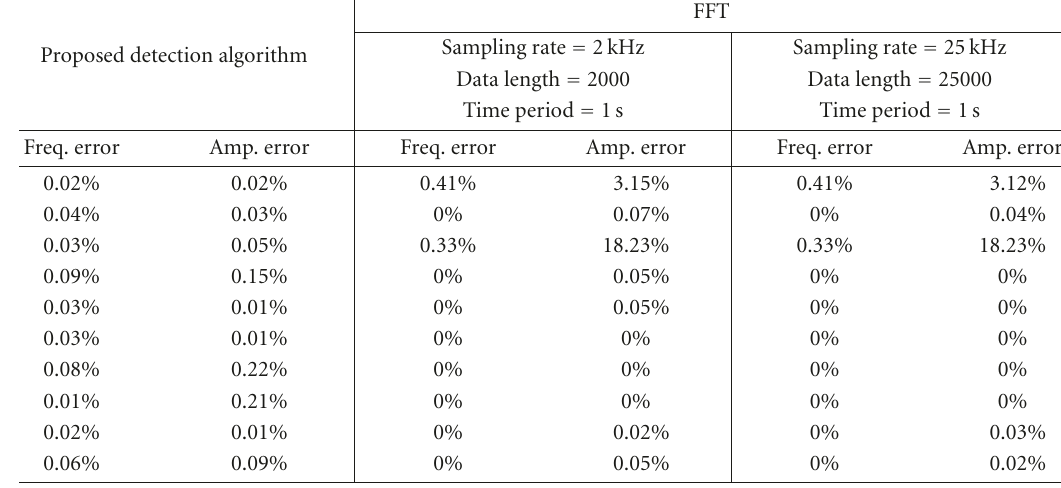
Table 6: Comparison of simulation results by the proposed detection algorithm and FFT.